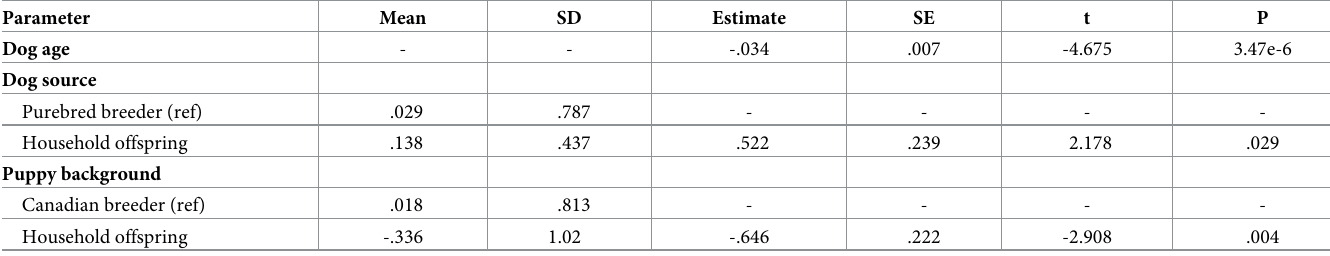
Table 11. Statistically significant interactions of owner and dog parameters on training methods Factor 2 “Gentle training”.